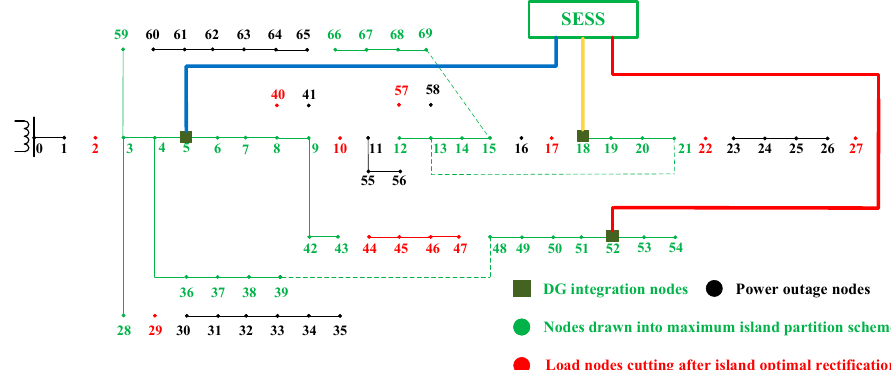
Figure 7. Final island partition scheme after island optimal rectification.